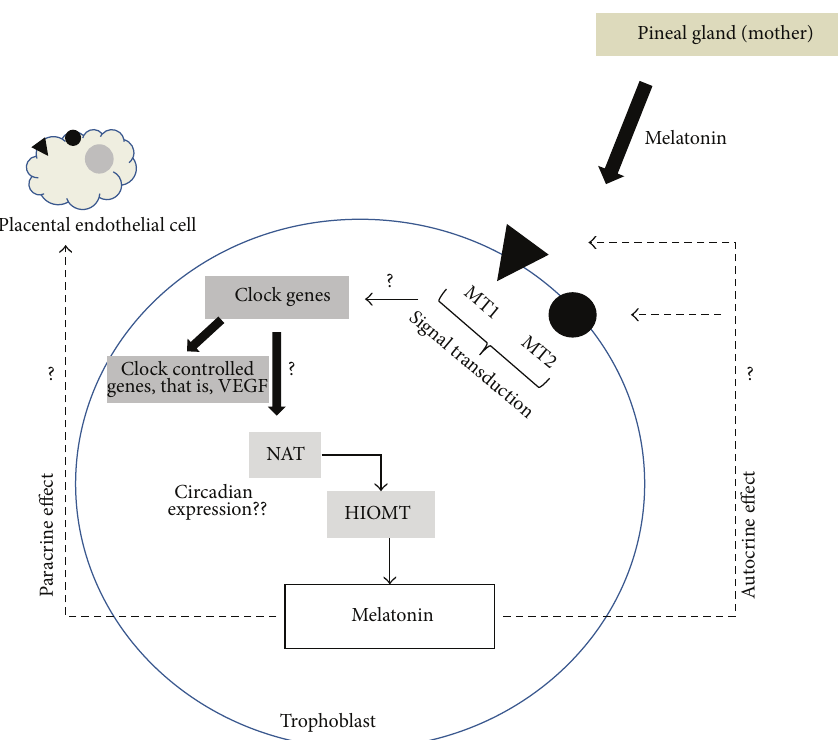
Figure 3: Autocrine and paracrine effects of melatonin over circadian system and enzyme of synthesis of melatonin localized in trophoblast and endothelial